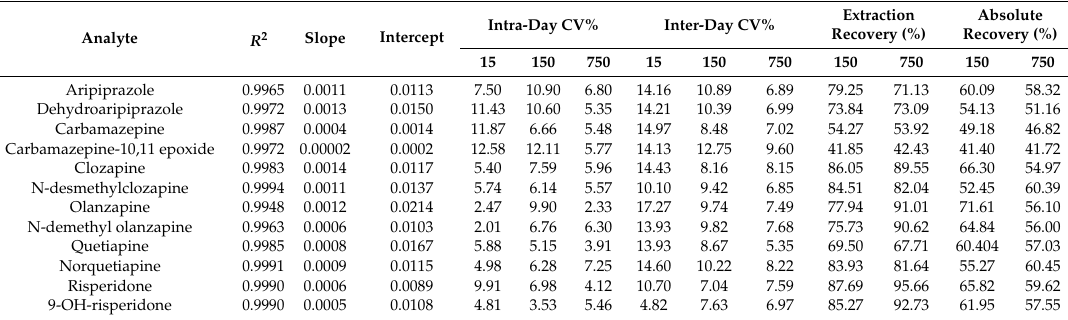
Table 1. Calibration curves (linearity in the range 10–1000 ng / mL) and validation parameters for the developed procedures.